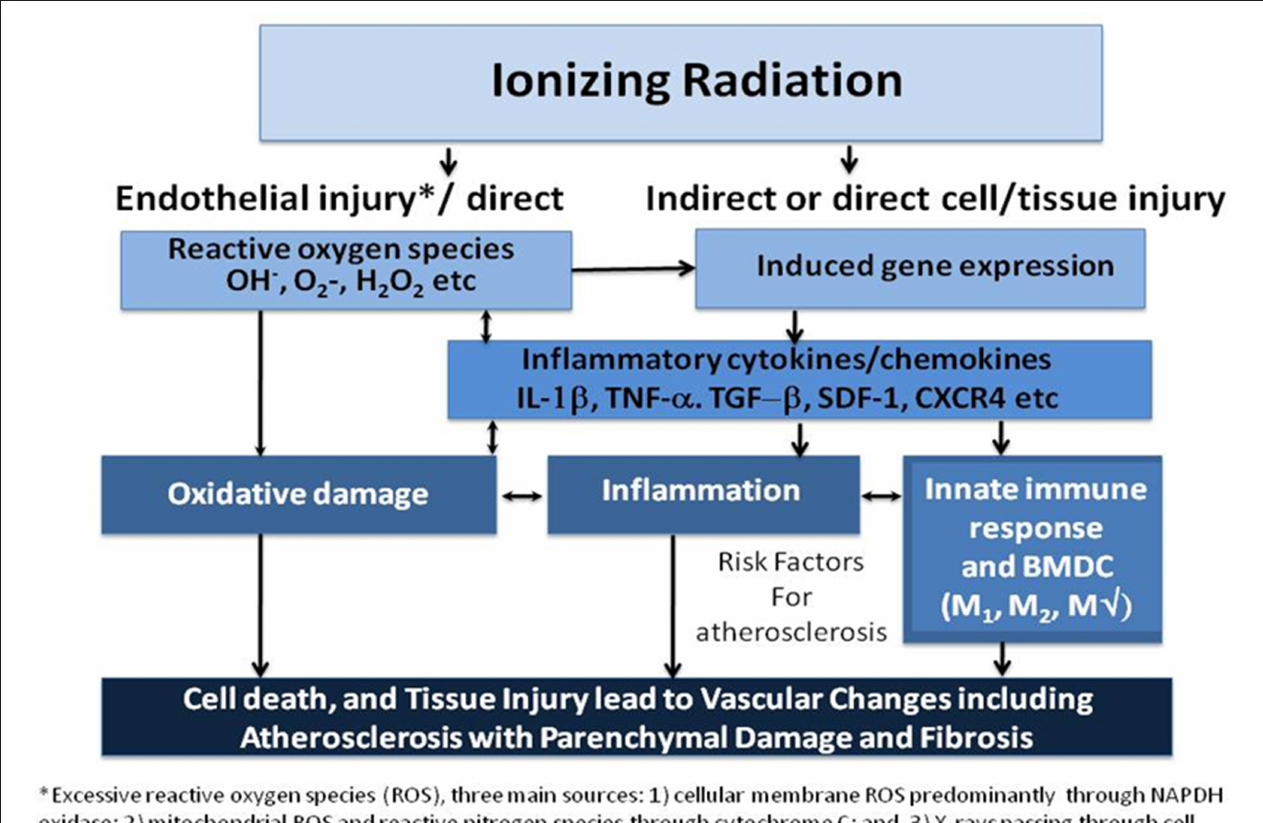
FIGURE 1 | Ionizing radiation causes cell death, both parenchymal and vascular, by multiple mechanisms. Historically, the direct cytotoxicity of radiation was the first identified pathway leading to tissue injury. More recently, another pathway involving inflammation has been identified. A third pathway has been studied in the last few years that implicates the innate immune response including bone marrow-derived cells (BMDC) and both M1, and M2 macrophage (M 8 ) in resultant tissue damage. Arrows represent influence of one mechanism on another and suggest potential targets for interfering with the process. Cell death and tissue injury result in accelerated atherosclerosis over 1 to 2 decades that may also result in parenchymal injury to the myocardium and the valves resulting in fibrosis [Modified from